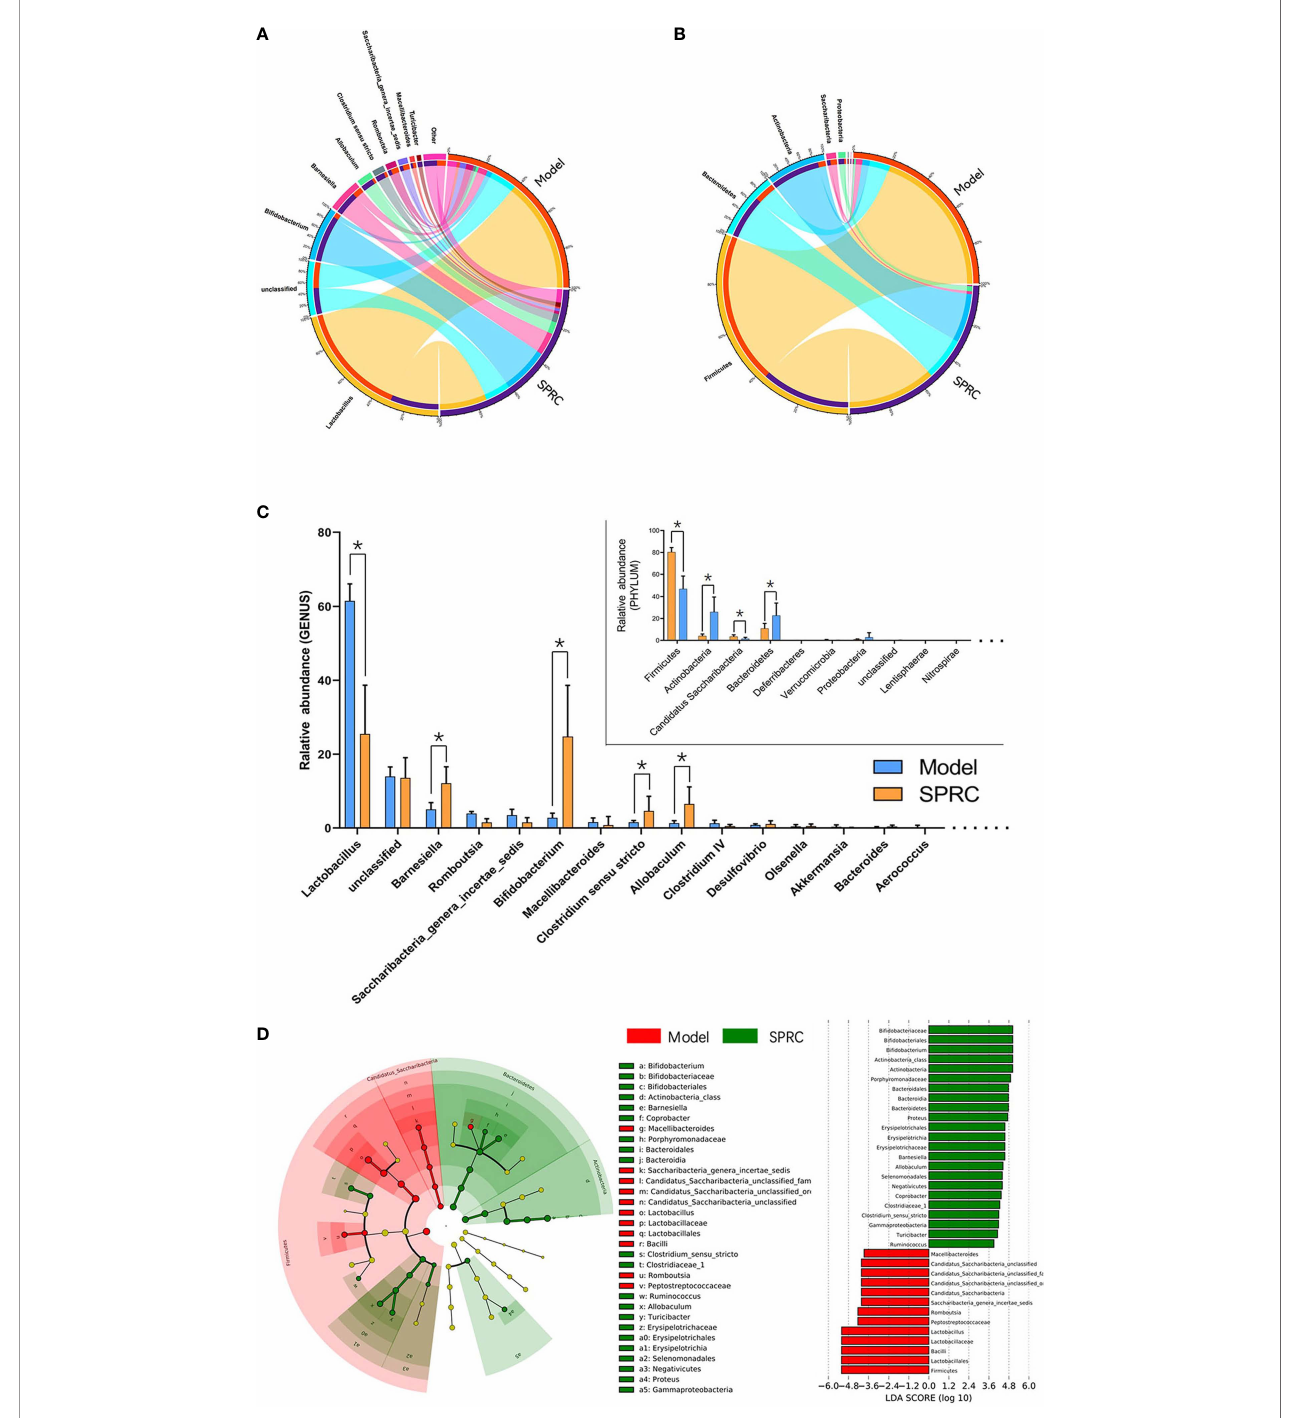
FIGURE 5 | Crucial bacterial candidate selection. The Circos graph shows the relative abundance of microbiota distributions at the phylum (A) and genus (B) levels between the Model and SPRC groups on the 28 th day. The left semicircle represents the phylum composition of each group, and the right semicircle indicates the distribution of each phylum in the different groups. (C) Bar plot showing the 10 most abundant phyla and 20 most abundant genera in the Model and SPRC groups, with marked asterisks (*) indicating signi fi cant differences (p < 0.05) between groups (n=10, means ± SD). (D) Differences in speci fi c taxa between groups were detected using LEfSe, and species with LDA scores higher than 3.6 were plotted. Differences between groups are represented by the color of the most abundant class (red indicates the Model group, and green indicates the SPRC group). The diameter of each circle is proportional to the relative abundance of the